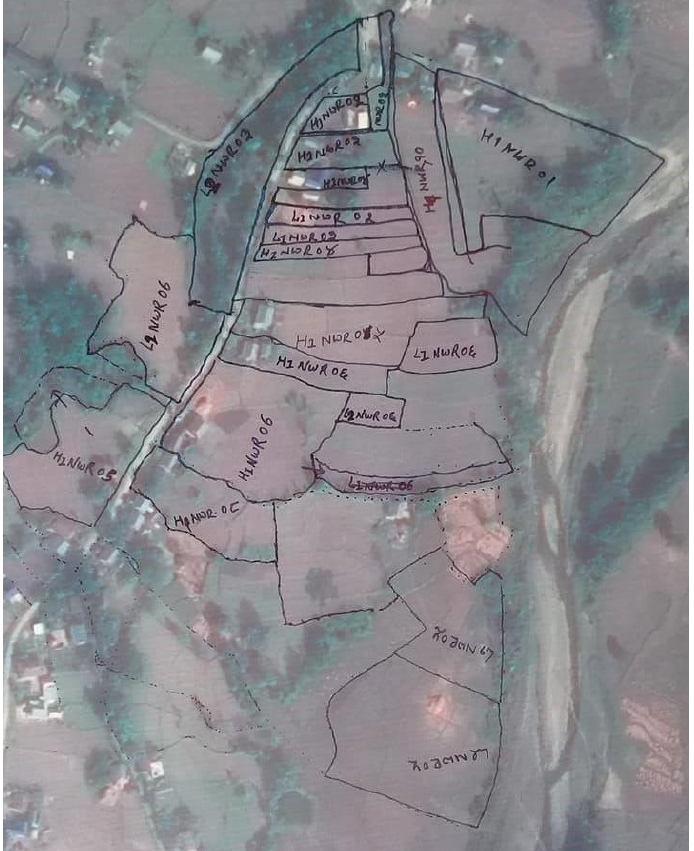
Figure 4. Delineating and coding spatial units on the printed satellite image map.